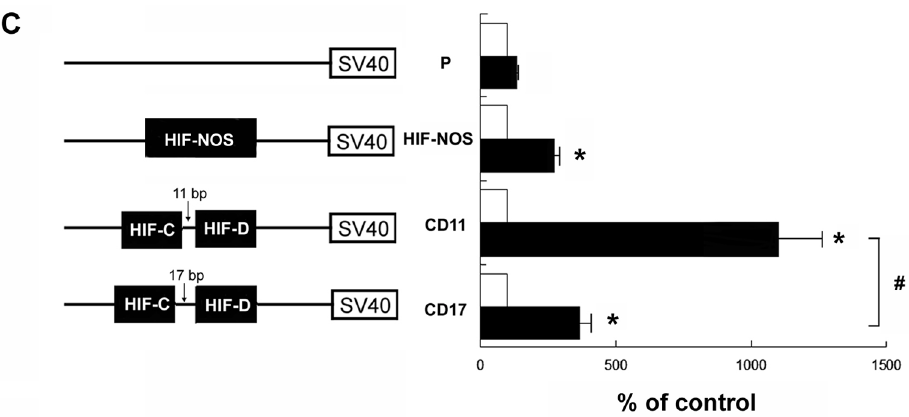
Figure 4. Effects of mutation and spacing of HIF C and D response elements of the hKOR gene on the luciferase reporter activity under DFO treatment. ( A , B ) Validation of the functional role of HIF C and D elements upon DFO challenge using the mutation analysis. The HIF consensus sequences were mutated to AA (depicted in ( A ) by underlines). The mutated fragment was cloned into the vector (pGL3-promoter). The resulting mutant plasmid (mCD11) was validated by DNA sequencing. NMB cells were transfected with the mCD11, CD11, and the pGL3-promoter vector (P), respectively. The pCH110 plasmid with the β -galactosidase was co-transfected and used as an internal standard. Transfected cells were treated without (control; white bars) or with DFO for 24 h (black bars). Cells were harvested and subjected to luciferase assay. The promoter activity of each construct under DFO treatment (black bars) was expressed as a percentage of non-DFO treated control activity, arbitrarily defined as 100% (white bars). Histograms represent mean values of activation. Error bars indicate S.E.M. Experiments were repeated at least ten times. “*” indicates p < 0.01 (student t -test). “#” indicates a significant difference ( p < 0.01; student t -test) between the CD11 and mCD11 activities; ( C ) the effect of topological arrangement of HIF C and D elements on the promoter activity under DFO treatment. The HIF C and D elements with a 17 bp spacing were cloned into the vector (pGL3-promoter). The resulting plasmid (CD17) was validated by DNA sequencing. NMB cells were transfected with the CD17, CD11, HIF-NOS, and the pGL3-promoter vector (P), respectively. The pCH110 plasmid as an internal standard was also co-transfected. Transfected cells were treated without (control; white bars) or with DFO for 24 h (black bars). Cells were harvested and luciferase assays were performed. The promoter activity of each construct under DFO treatment (black bars) was expressed as % of non-DFO treated control activity of individual plasmid (white bars), arbitrarily defined as 100%. Histograms represent mean values of activation. Error bars indicate S.E.M. Experiments were repeated at least six times. “*” indicates p < 0.01 (student t -test). “#” indicates a significant difference ( p < 0.01; Student t -test) in reporter activities between the CD11 and CD17 plasmids.